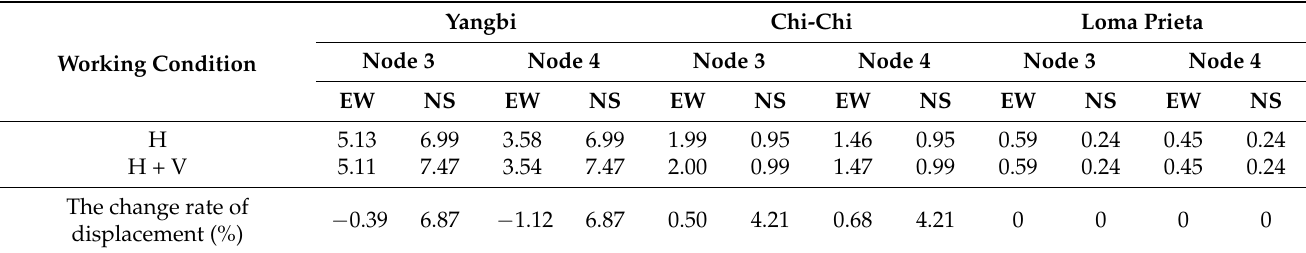
Table 6. Maximum displacement of the top layer in the EW and NS directions/mm.